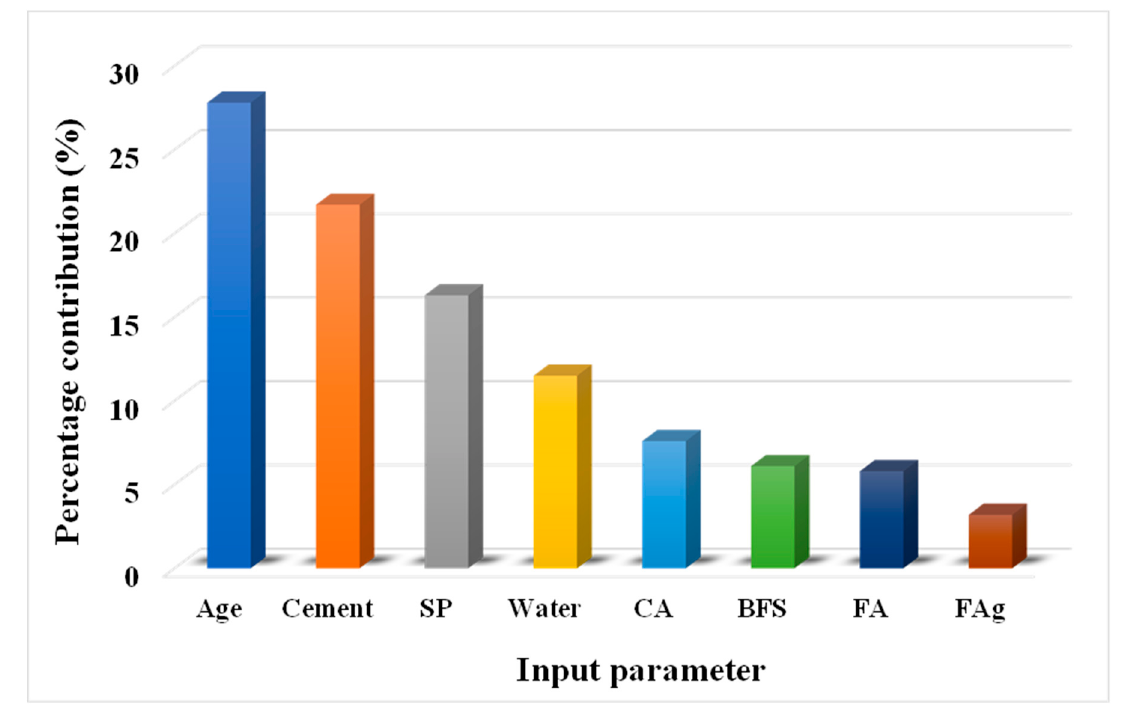
Figure 11. Sensitivity analysis of various contributing parameters towards the prediction. SP: superplasticizer, CA: coarse aggregate, BFS: blast furnace slag, FA: fly ash, FAg: fine aggregate.